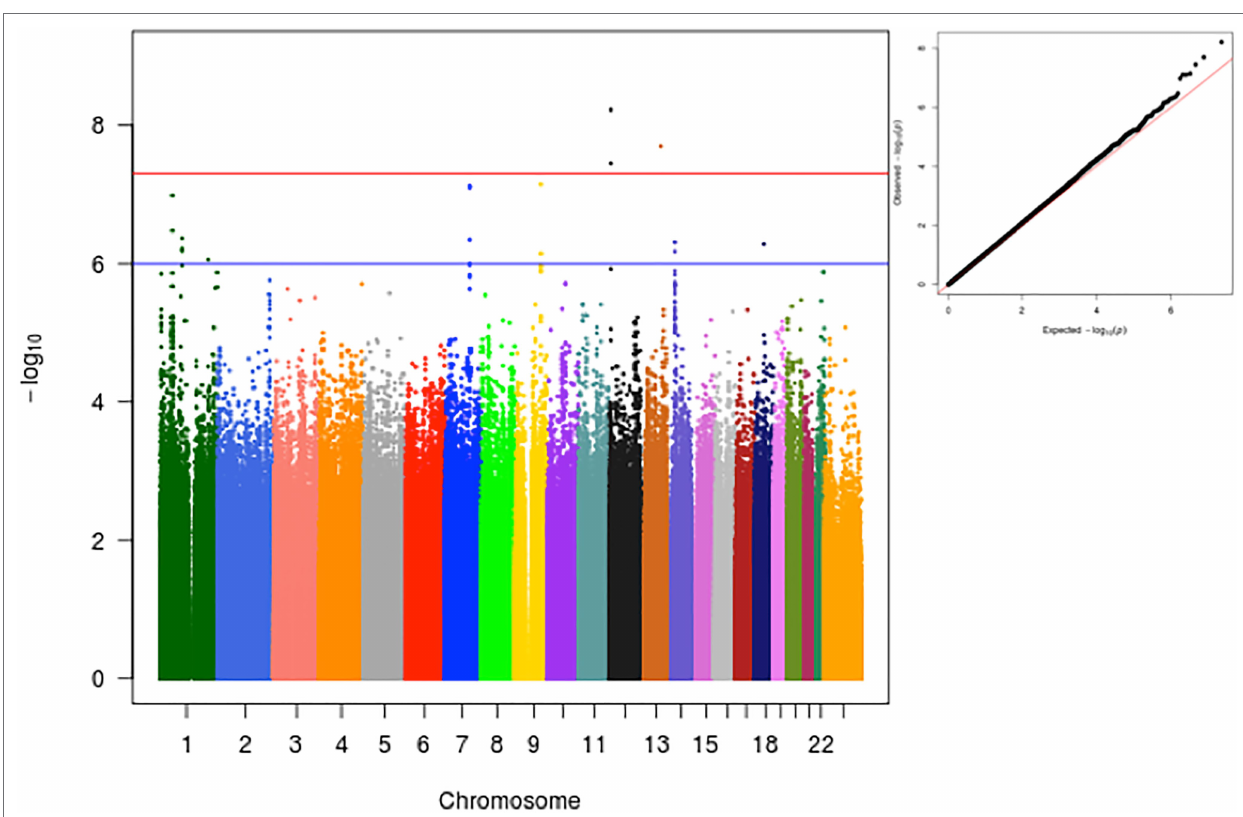
FIGURE 1 | Manhattan and qqplot of GWA analysis for log-transformed PCSK9 as a function of variant, age, sex and the first 4 Principal Components.